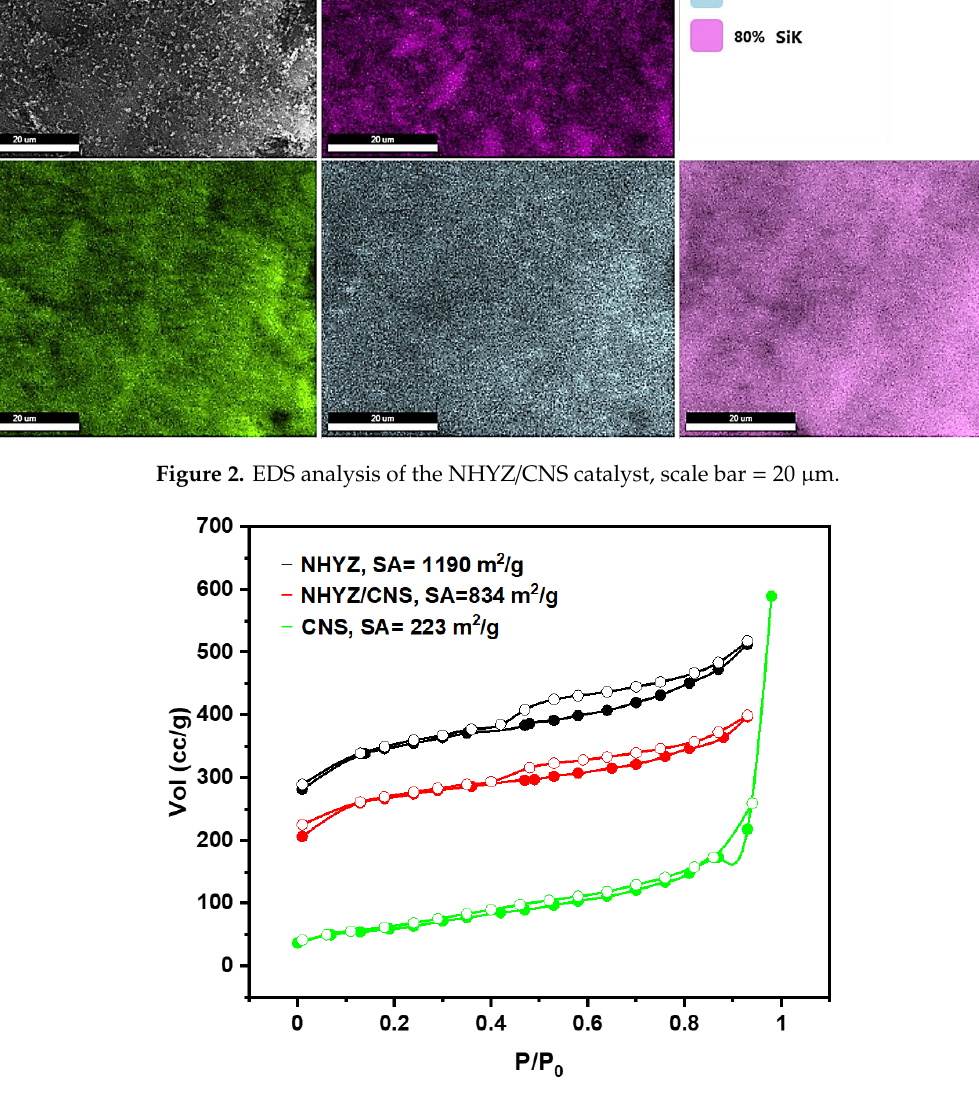
Figure 3. N 2 adsorption / desorption isotherm of NHYZ, NHYZ / CNS, and CNS, filled circles represent adsorption and empty circles represents desorption, SA = surface area.